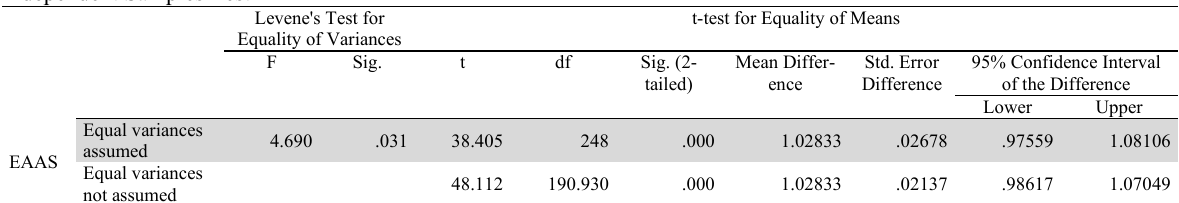
t-test for Equality of Means